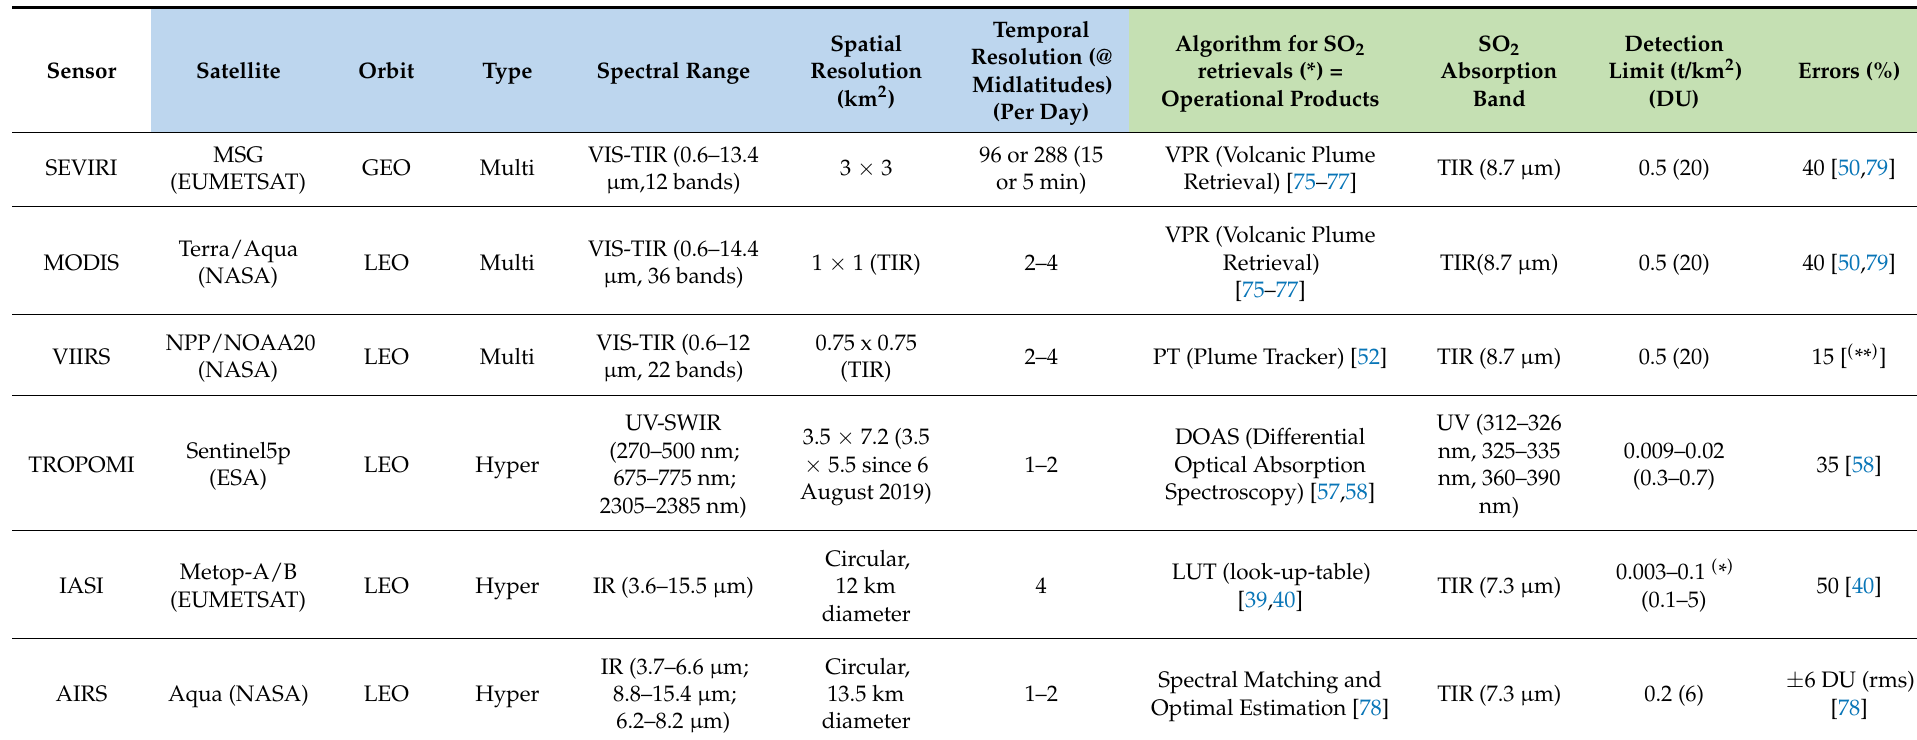
Table 1. Satellite sensors and SO 2 retrieval algorithm characteristics. SO 2 detection limits adapted from [58]. ( * ) 0.1 DU is for the UTLS and 5 DU is for the lower troposphere/boundary layer. ( ** ) V. Realmuto, personal